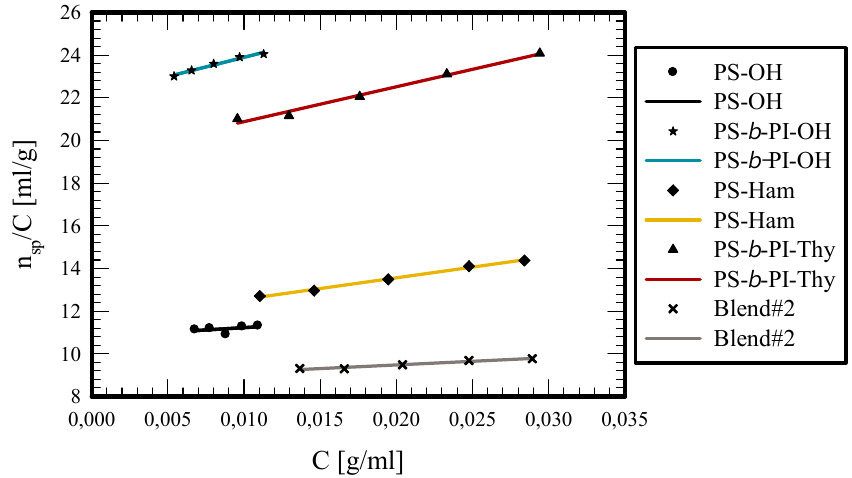
Figure 14. Huggins plots for samples PS ‐ OH, PS ‐ b ‐ PI ‐ OH, PS ‐ Ham, PS ‐ b ‐ PI ‐ Thy, and Blend #2.